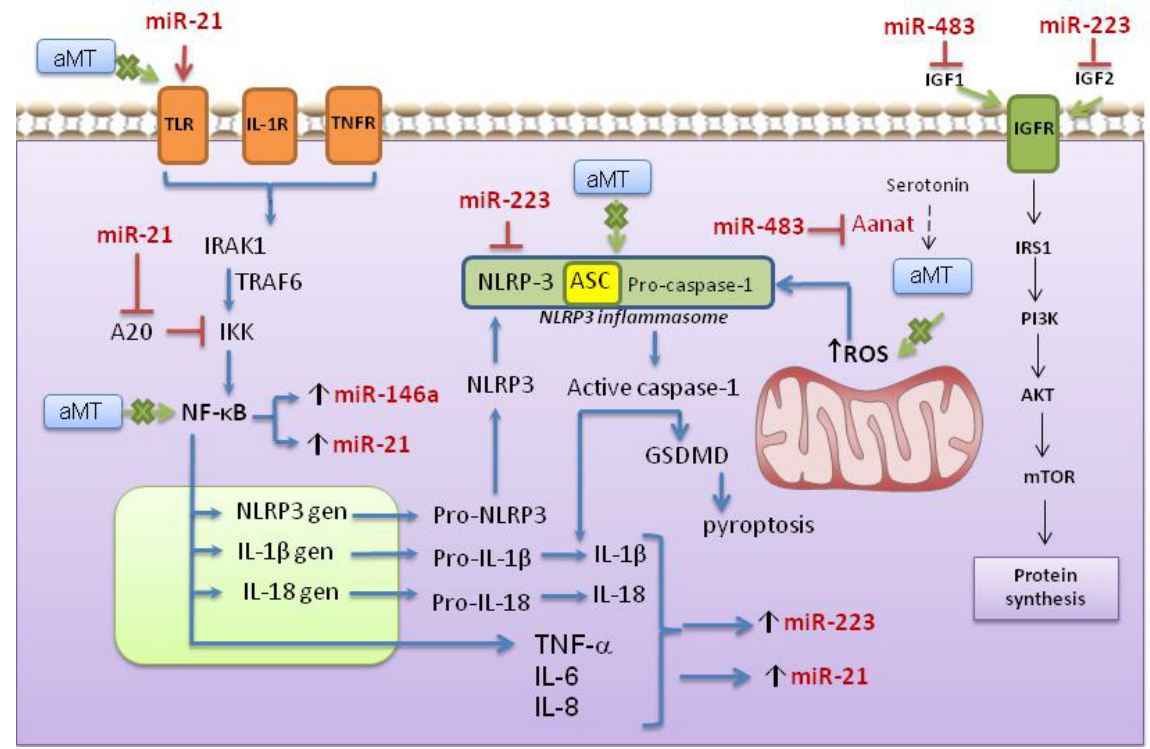
Figure 8. NF- κ B pathway and NLRP3 inflammasome activation and role of some microRNAs. The priming signal acts through Toll-like receptor (TLR), specific receptors IL1-R, or TNFR that leads to the activation of NF- κ B and subsequent production of pro-IL-1 β , pro-IL-18, and pro-NLRP3. The second activation signal is provided by multiple events, including mitochondrial dysfunction, and reactive oxygen species (ROS) generation, among others, that damage mitochondria, opening the MPP releasing ROS and mtDNA to the cytosol. These signals activate NLRP3 inflammasome, that in turn causes caspase-1-depending IL-1 β and IL-18 maturation. In conditions of high cytokine production, IL-1R and TNFR signaling activate the downstream kinase IRAK1 (interleukin-1 receptor-associated kinase 1), and TRAF6 (TNF receptor-associated factor 6), finally resulting in activation of NF- κ B pathway that directly yields miR-146a and miR-21. miR-21 may act directly on TLRs and/or targeting A20 [15], activating NF-kB pathway. Moreover, the NF- κ B-dependent TNF- α, IL-6, IL-8, as well as IL-1 β and IL-18 production, the later ones activated by the NLRP3 inflammasome, increase miR-21 and miR-223 expression, the latter regulating NLRP3 inflammasome activation [6]. miR-223 and miR-483, acting through their target insulin-like growth factor (IGF)-2 and IGF-1, respectively, regulate the PI3K/AKT/mTOR pathway and blunt rates of protein synthesis [42,43]. Arylalkylamine-N-acetyltransferase (aanat) is the enzyme involved in melatonin synthesis and is a target for miR-483 [22]. The participation of melatonin is described in the text below. Thus, the reduction of pro-IL-1 β due to the lack of NLRP3 may explain the drop of the expression of miR-21 in aged animals. Some authors suggest that, besides proin-